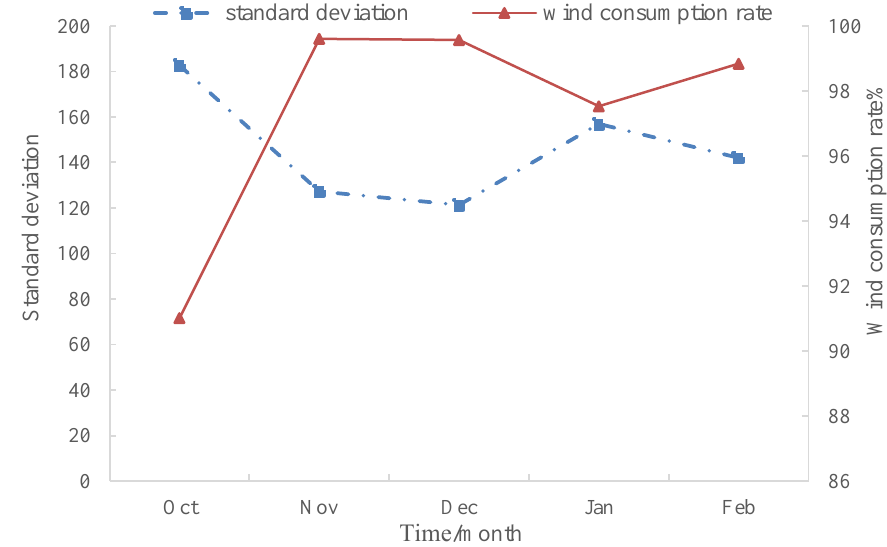
Figure 10. The wind power consumption rates of different months with